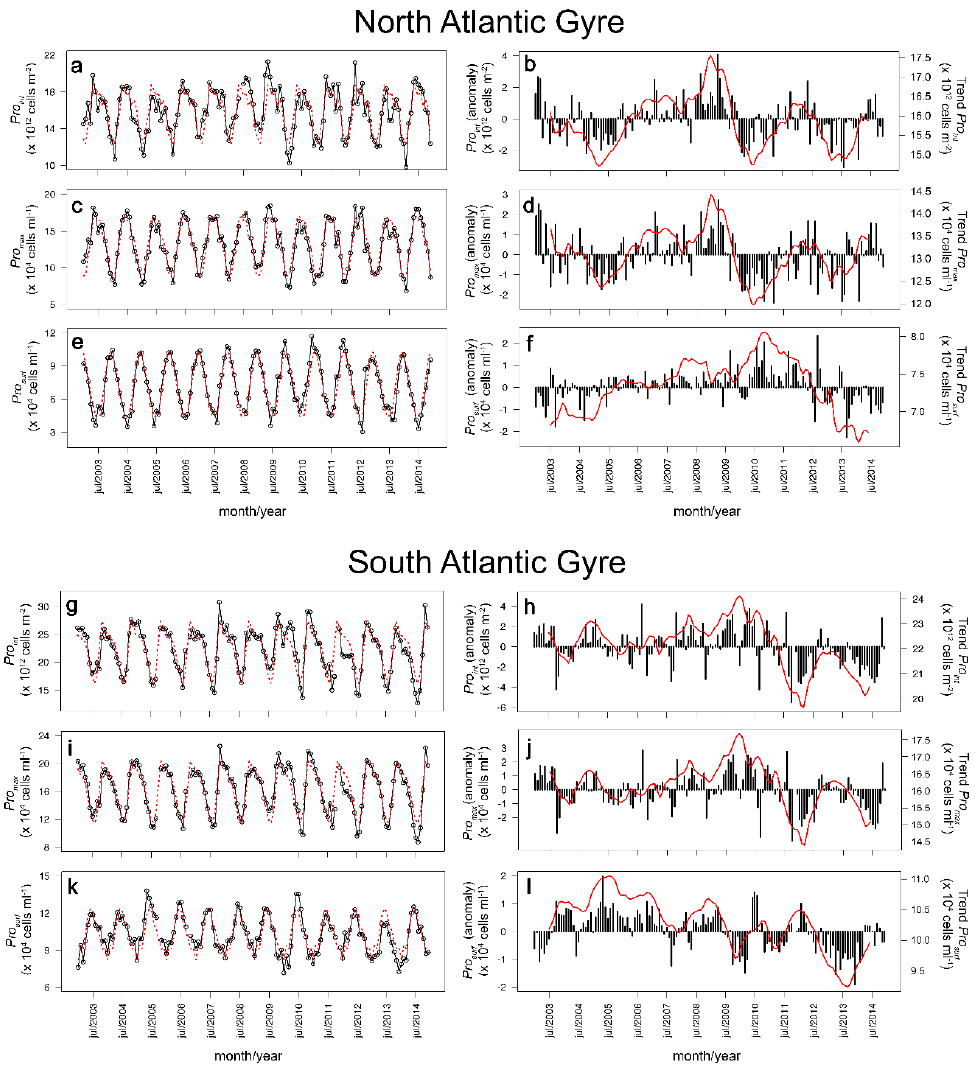
Figure 10. Time series of ( a , g ) the estimated Prochlorococcus cell abundance integrated in the water column ( Pro int ), ( c , i ) estimated Prochlorococcus cell abundance at the deep maximum ( Pro max ), and ( e , k ) estimated Prochlorococcus cell abundance at surface ( Pro surf ), at one location (26 ◦ N, 50 ◦ W) in the North Atlantic Gyre (NAG) ( a – f ), and one location (20 ◦ S, 20 ◦ W) in the South Atlantic Gyre (SAG) ( g – l ). Figures ( b , d , f , h , j , l ) show the time-series anomalies (black bars) and trends (red lines). Anomalies were calculated by subtracting the monthly climatology (dashed red lines in figures ( a , c , e , g , i , k )) from the calculated values for each month (black lines in figures ( a , c , e , g , i , k )). In general, the standing stock of Prochlorococcus cells integrated over the gyre area is 1.7 times higher in the South Atlantic Gyre (SAG) than in the North Atlantic Gyre (NAG) (Table 4), regardless of the season (Figure 9k,l). No clear long-term temporal changes of Pro int and Pro max were observed in either of the gyres (Figure 10a,b,g,h), although a mode shift (between positive and negative anomalies) of approximately 3–5 years was observed in the NAG (Figure 10a,b). Pro surf decreased in the SAG (Figure 10k,l), whereas in the NAG there was an increase in cell abundance from 2002 to 2011, followed by a steep decrease from 2012 to 2014 (Figure 10e,f), which could be associated with the degradation of MODIS R rs signals that started in